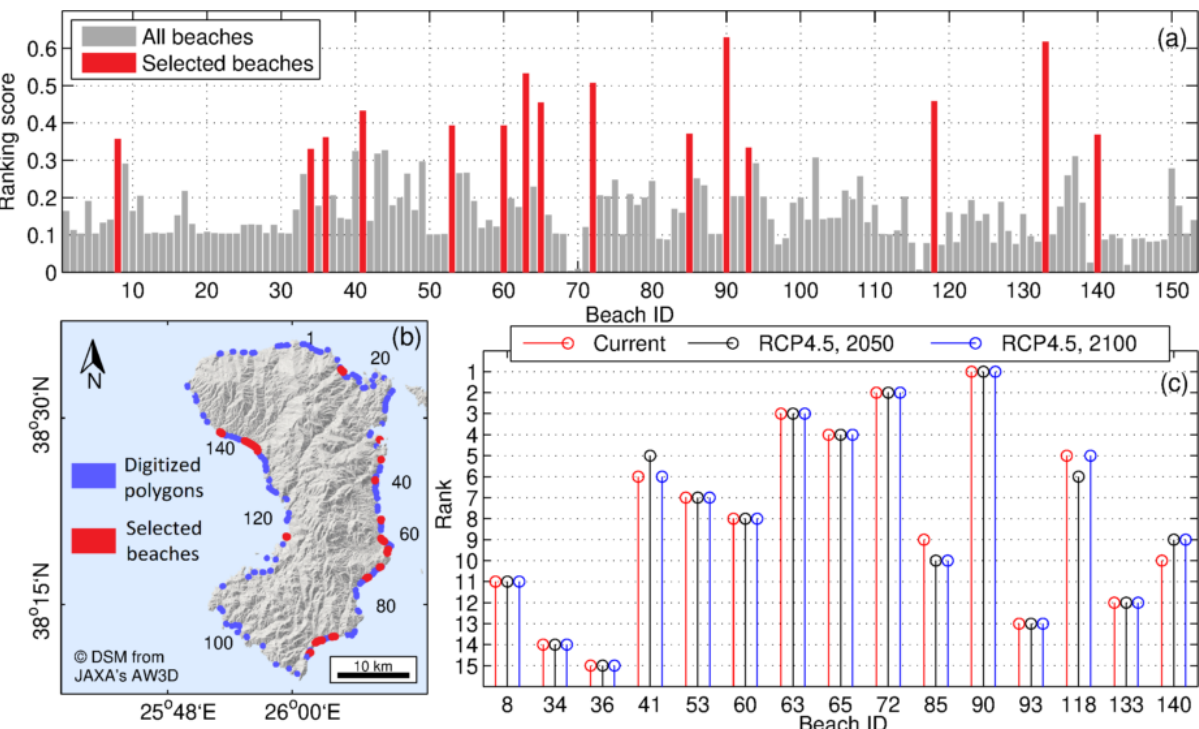
Figure 3. ( a ) Ranking scores of all 153 recorded beaches of Chios (TOPSIS method) according to their socio-economic and environmental significance; the 15 most highly ranked beaches are shown in the red color; ( b ) digitized polygons of the beaches (clockwise beach numbering starting from the north) and selected beaches; ( c ) ranking scores of the 15 selected beaches (AHP method) based on their vulnerability to CV&C (under current and future